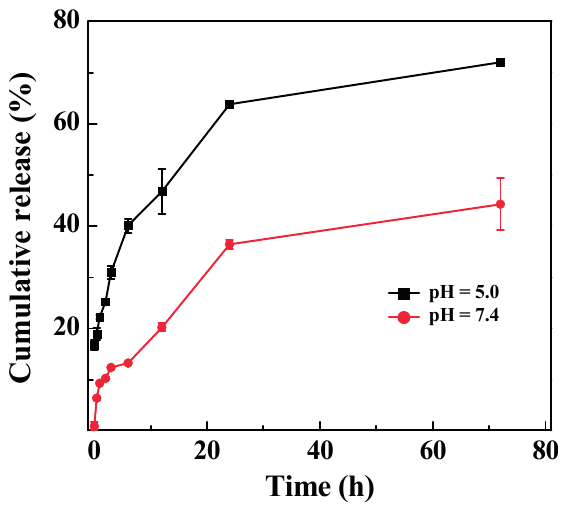
Figure 5. In vitro release of DOX from the LM-G2/DOX nanodisks at 37 °C under different pH conditions (pH = 5.0 and 7.4).